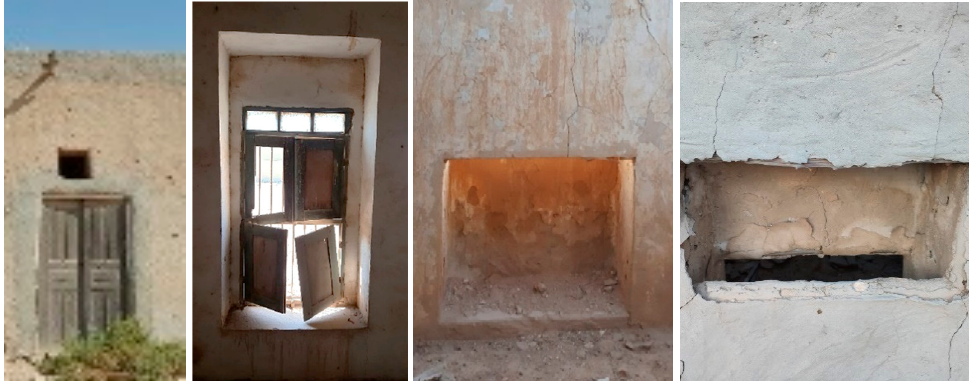
Figure 17. From left to right, Picture 1 shows a permanent opening above the room entry door used for cross ventilation. Picture 2 shows the details of the window. It has four shutters to reduce the daylight and to provide privacy. In addition, there is a row of three fixed glass panels on the top. Its location above the visual level ensures privacy to the occupants. Pictures 3 and 4 show the malqaf, the first from inside the room and the second from outside.